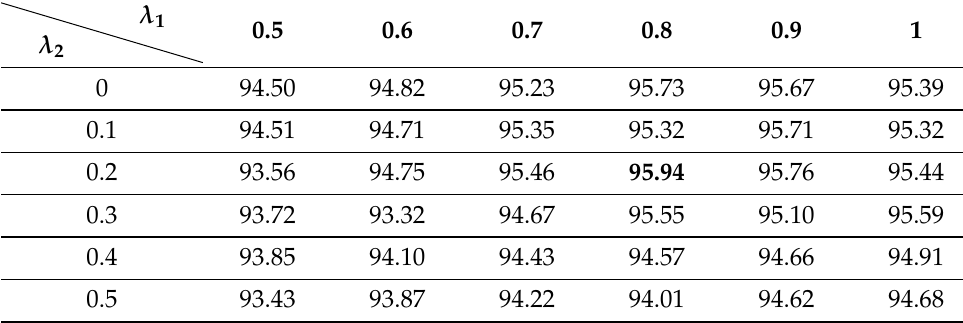
Table 6. Overall accuracy in the Indian Pines data set with different λ 1 and λ 2